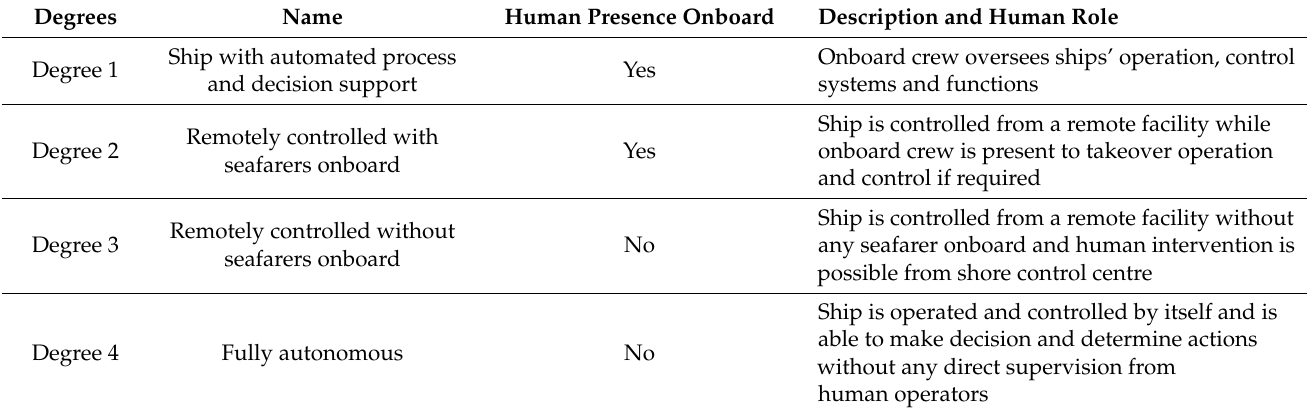
Table 1. Levels of autonomy in MASS by IMO and associated human roles